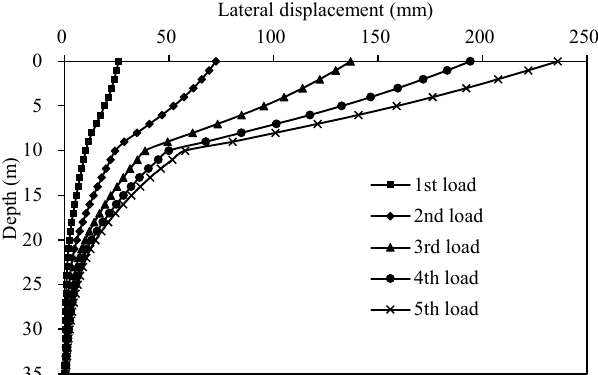
Figure 8. The lateral displacement of the steel pipe pile along the depth after each loading. Figure 9 shows the distribution of the lateral displacement of the foundation soil at the end of the 5th lift loading. Six locations were marked in Figure 2. Their horizontal distances away from the center of the pile were 1, 6, 11, 16, 21, and 36 m, respectively. The distribution pattern of the lateral displacement of the foundation soil was different from that for the steel pipe pile. The maximum lateral displacement happening in relation to the depth varied from 1 to 4 m in different cases rather than the ground surface. The lateral displacement first increased to a maximum value with the increase in depth and then decreased to zero with the increase in depth. The lateral displacement was slight when the depth exceeded 30 m—the position of the maximum lateral displacement moved downward and was not on the ground surface. The maximum lateral displacement decreased with the increase in distance away from the center of the pile. The maximum lateral displacement of the foundation soil was 191.0, 153.0, 103.0, 28.6, 20.7, and 6.4 mm, respectively, for cases with horizontal distances of 1, 6, 11, 16, 21, and 36 m. Interestingly, the lateral displacement at the ground surface sharply decreased as the distance increased from 1 to 6 m. It can be concluded that the major influence zone of the lift loading was about 11 m in horizontal distance away from the center of the pile.